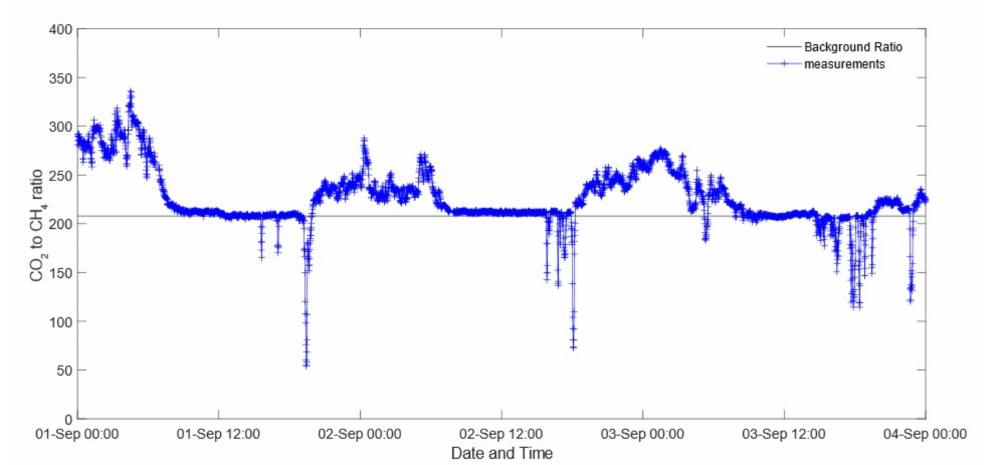
Figure 5. Values of the CO 2 /CH 4 ratio over 1–4 September 2016, measured at the Stary Wiec station.